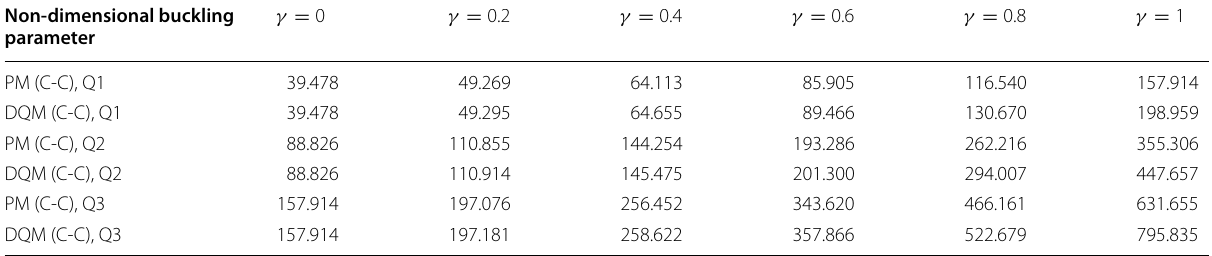
Table 5 Comparison between PM and DQM for the non-dimensional buckling parameter of clamped–clamped non-prismatic rectangular beam